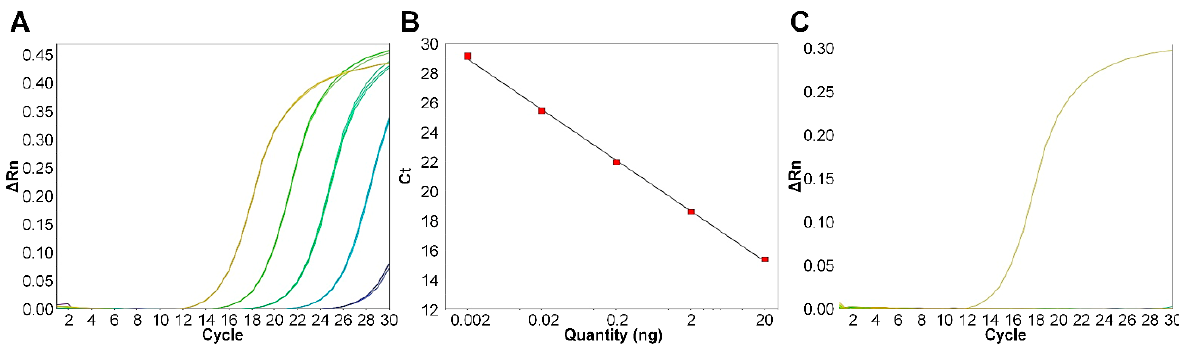
Figure 5. Performance of the diagnostic primer set in real-time PCR. ( A ) Amplification plots obtained from serial dilutions of S . Infantis CCARM 8283 genomic DNA from 20 ng to 2 pg: yellow, 20 ng; yellow-green, 2 ng; green, 200 pg; cyan, 20 pg; and blue, 2 pg. ( B ) The standard curve of dependence of C t values ( Y ) on genomic-DNA amounts ( X ) corresponded to the equation Y = − 3.42 X + 19.983 (R 2 = 0.999). ( C ) Specificity of the primer set in relation to 60 Salmonella strains. None of the strains yielded amplification, except S . Infantis CCARM 8283. Strains tested in ( C ) are listed in Supplementary Table S2.